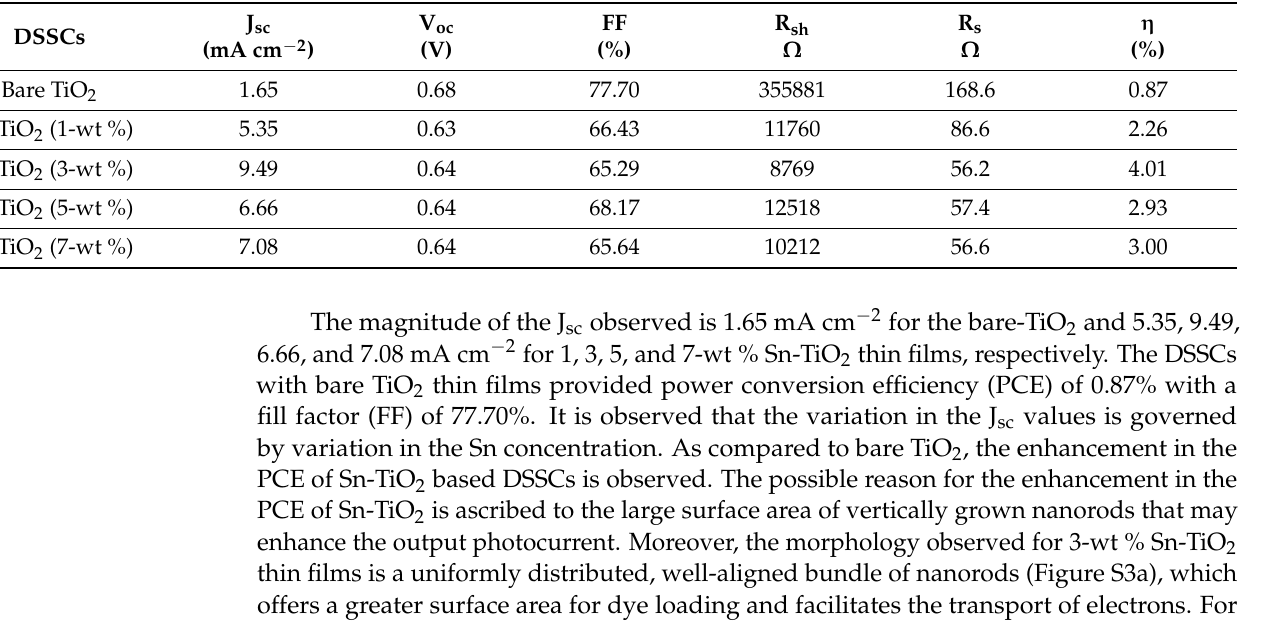
Figure 5. ( a ) The graphical view of 1D and 3D Sn-TiO 2 nanorods based DSSCs ( b ) The Photocurrent density–photovoltage (J–V) curves of dye-sensitized bare TiO 2 and Sn-TiO 2 photoelectrodes with different Sn concentrations. Table 2. Performance characteristics of DSSCs based on the bare-TiO 2 and Sn-TiO 2 photoelectrodes with varying Sn concentrations.